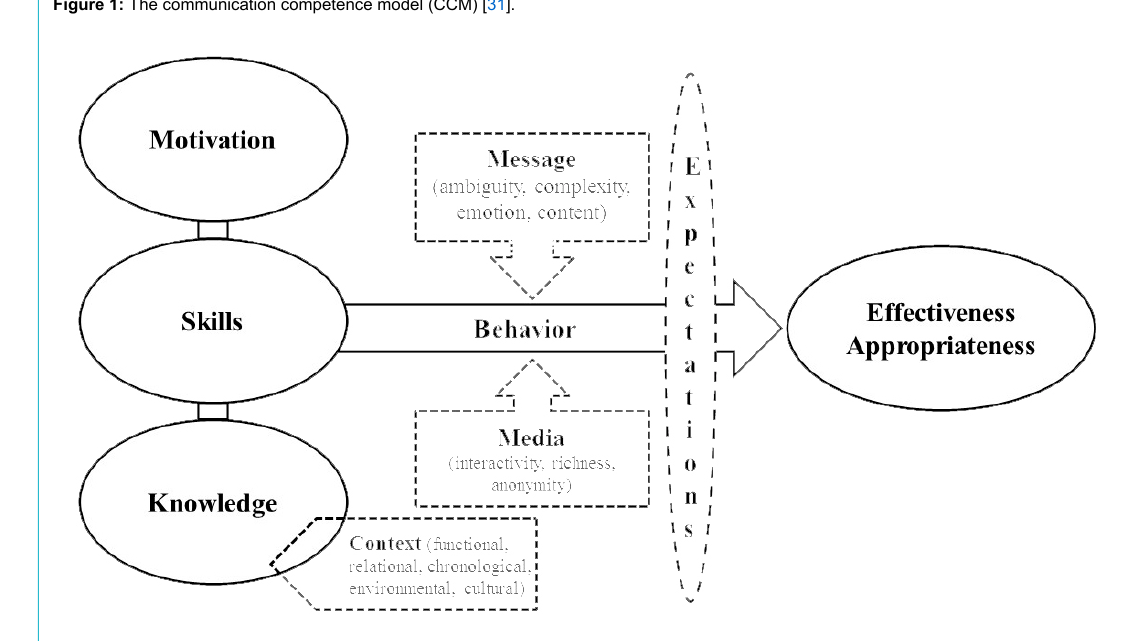
Figure 1: The communication competence model (CCM)